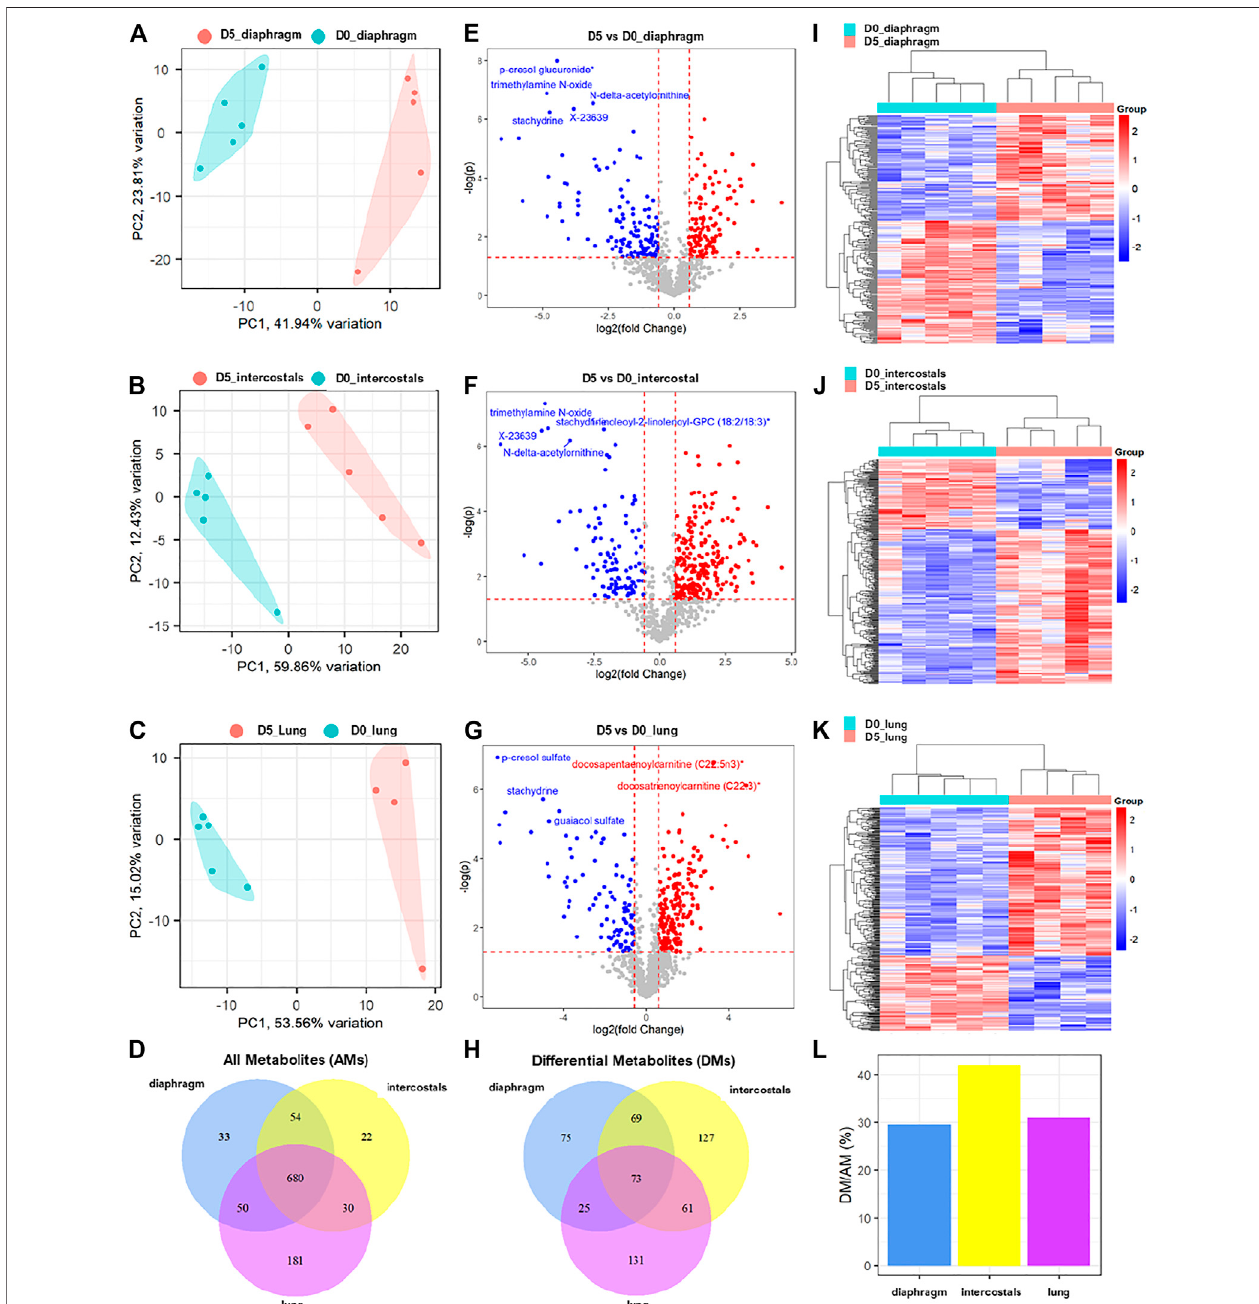
FIGURE 1 | The alterations of metabolomic pro fi les in diaphragm, intercostals, and lung tissue in response to 5-day CMV. Principal component analysis of metabolomicpro fi lesin (A) diaphragm, (B) intercostals,and (C) lungtissue. (D) Venndiagramofalldetectedmetabolites(AMs)amongtissues.Volcanoplotofdifferential metabolites ( p < 0.05, absolute fold change ≥ 1.5) in response to 5-day CMV in (E) diaphragm, (F) intercostals and (G) lung tissue. (H) Venn diagram of differential metabolites (DMs) among tissues. Hierarchical clustering analysis of differential metabolites in (I) diaphragm, (J) intercostals and (K) lung tissue. (L) percentage of differential metabolites in all metabolites detected in each tissue. D0: rats without controlled mechanical ventilation ( n = 5); D5: rats subject to controlled mechanical ventilation ( n = 5 for diaphragm and intercostal; n = 4 for lung).